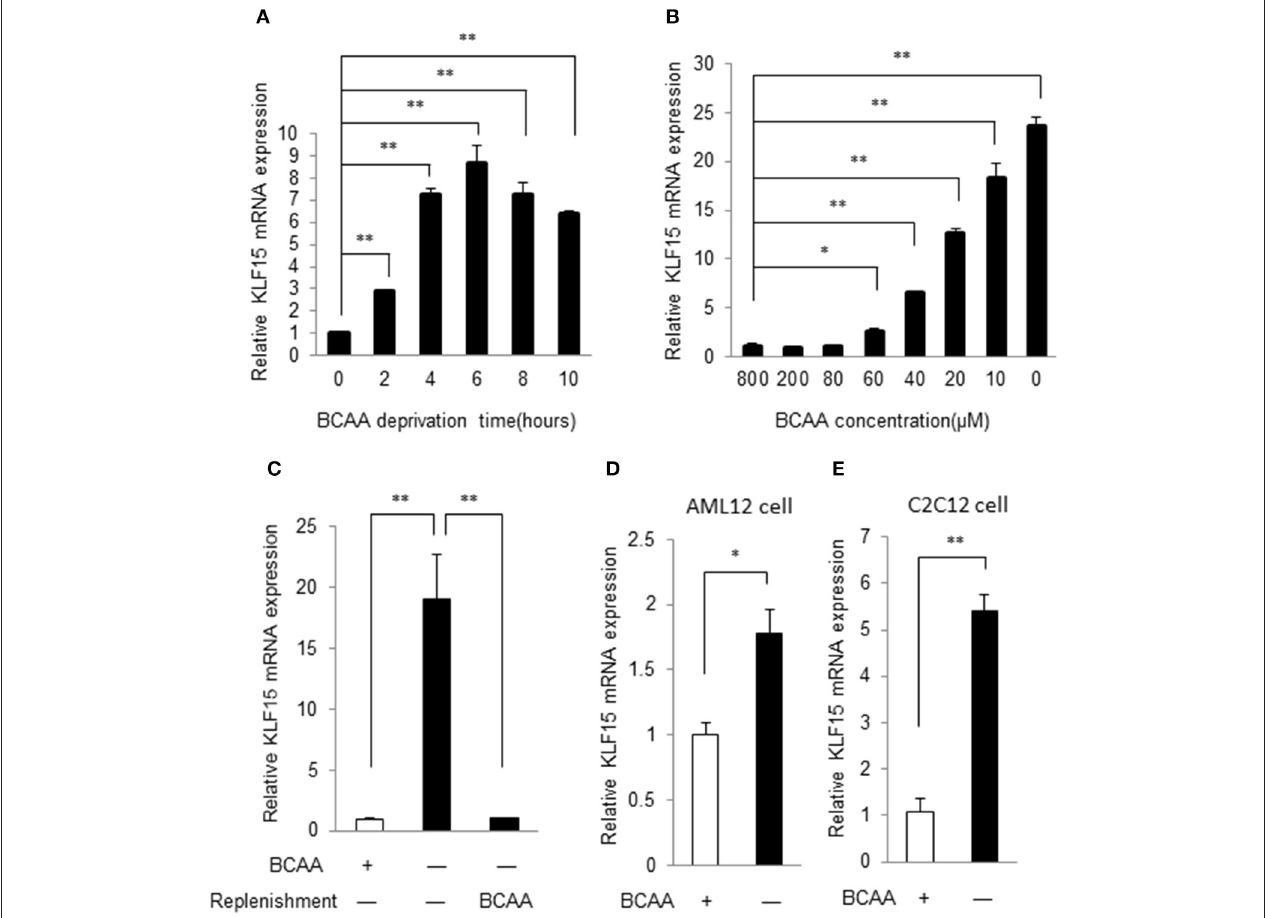
FIGURE 1 | BCAA negatively controls KLF15 expression. Quantitative PCR results of KLF15 in MEFs. (A) MEFs were cultured in BCAA-free DMEM for indicated time before harvesting. (B) MEFs were cultured with different concentrations of BCAAs for 6h before harvesting. (C) MEFs were cultured without BCAA ( − ) for 4h followed with or without ( − ) BCAA replenishment for extra 2h before harvesting. (D,E) , AML12 liver cell line (D) and C2C12 muscle cell line (E) were cultured with ( + ) or without ( − ) BCAA for 4h before harvesting. Data are means ± SE for three individual samples. * p < 0.05, ** p < 0.01.